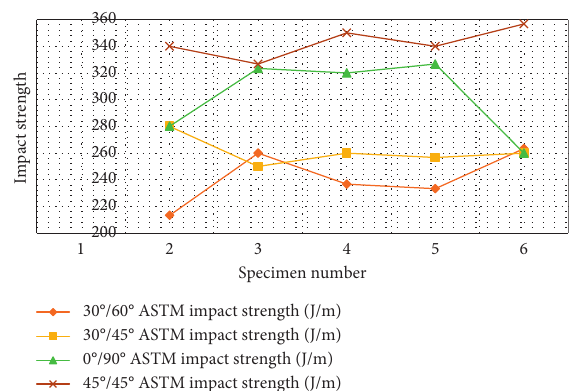
Figure 12: Impact strength of five specimens in each orientation type.